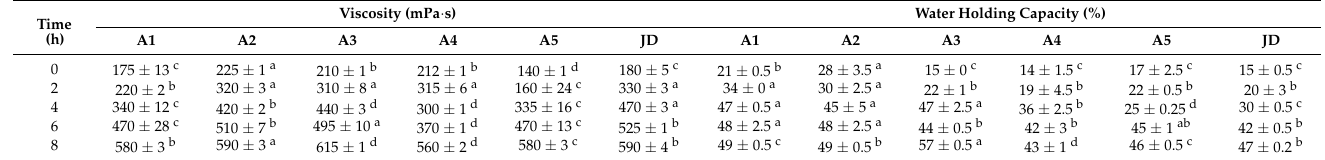
Table 2. Differences in water holding capacity and viscosity of yogurts produced through fer- mentation using different ratios of L. delbrueckii subsp. bulgaricus IMAU20312 and S. thermophilus IMAU80809 in starter cultures compared with the commercial starter